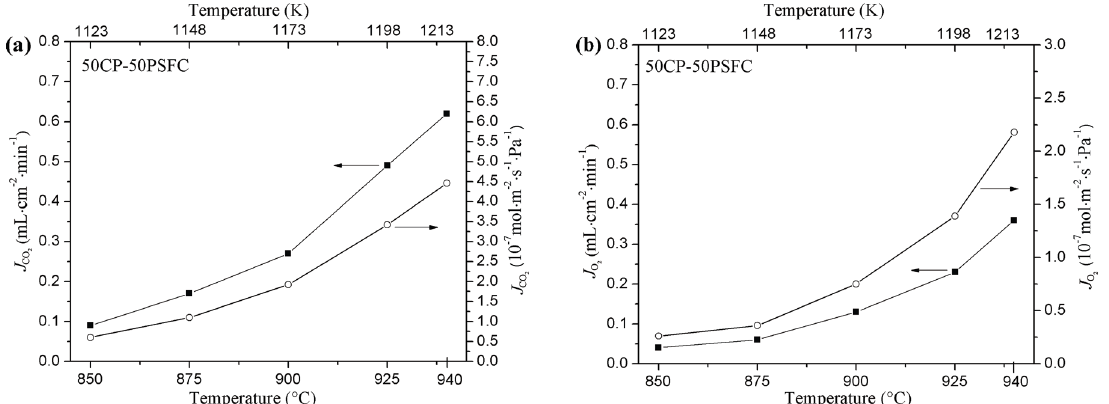
Fig. 8 Experimental permeation fluxes observed in the studied temperature range for the 50CP–50PSFC/carbonate membrane: and (b) J O . (a) J CO 2 2